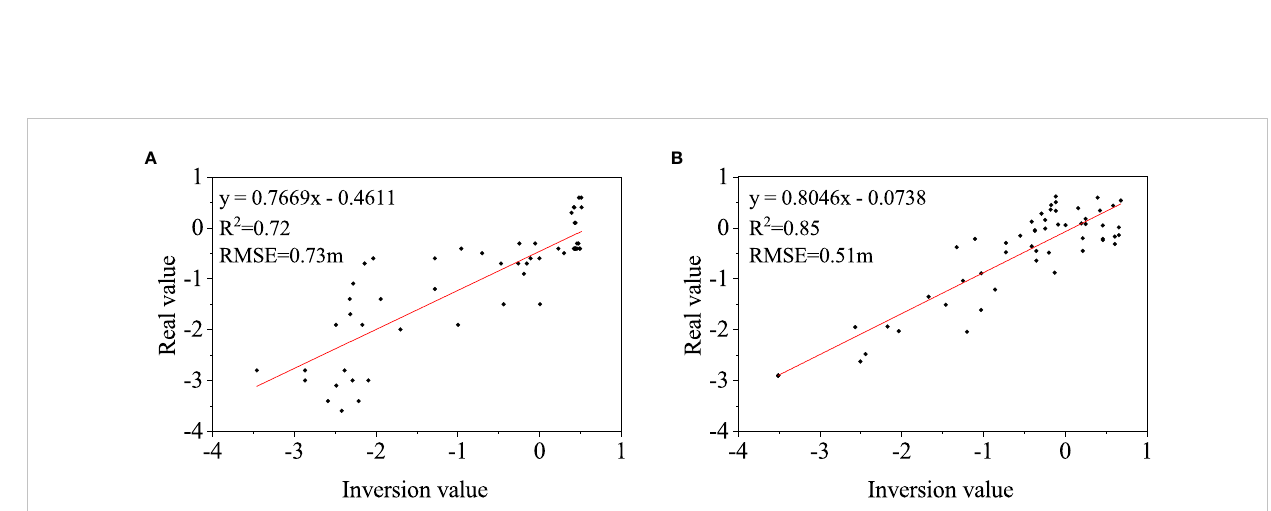
FIGURE 4 Linear relationships between the interpolated DEM and the measurement values in 2011 (A) and 2015 (B)